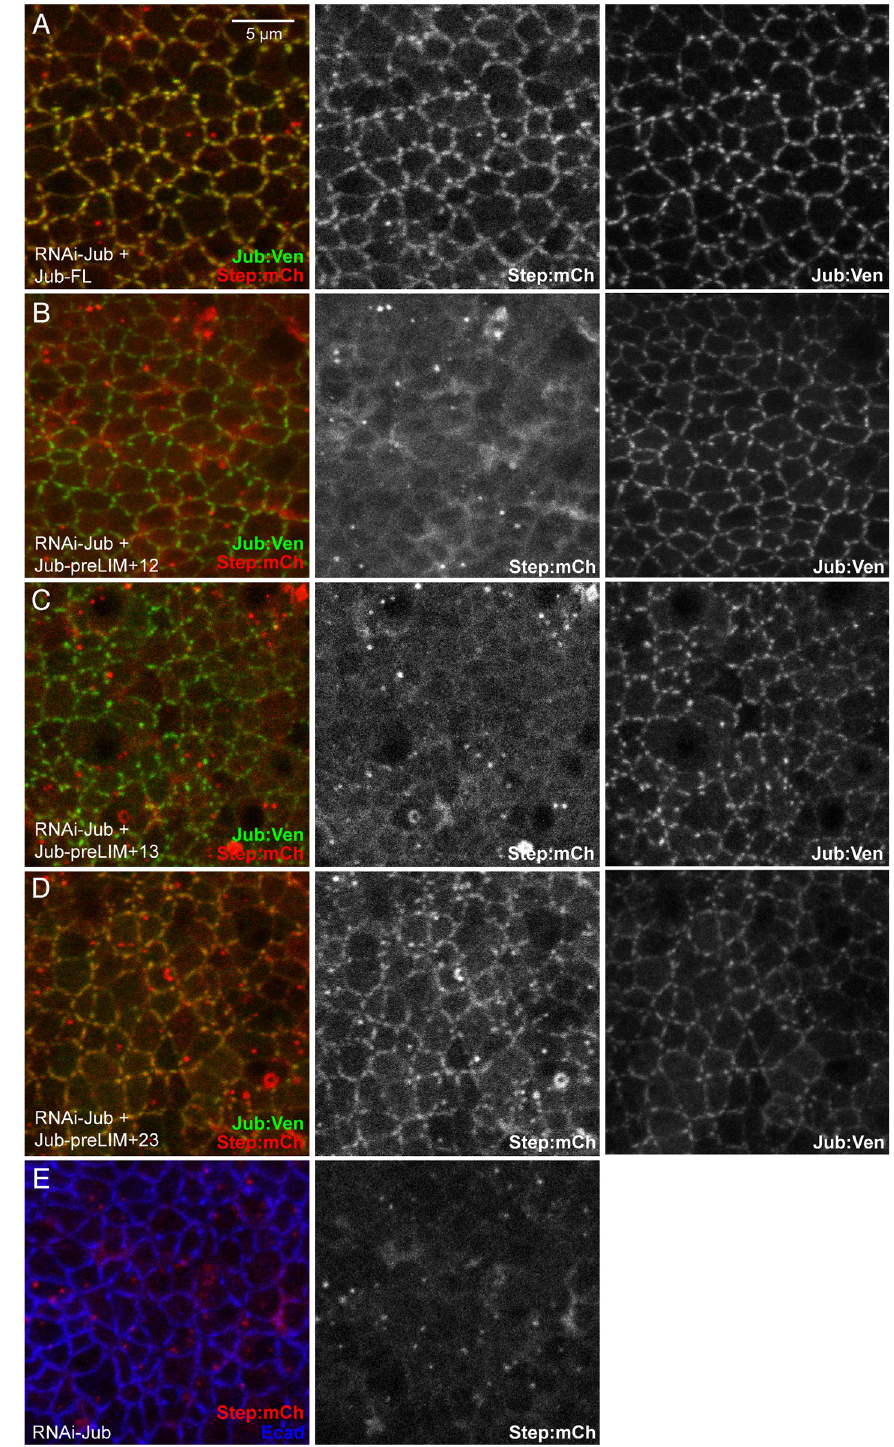
Fig 7. Rescue of junctional Step by Jub deletion constructs. A-E) Representative wing discs from larvae expressing Step:mCherry (red/white), nub-Gal4 UAS-Dcr2 and A) UAS-RNAi-jub UAS-Jub-FL : msVenus . B) UAS-RNAi-jub UAS-Jub-preLIM+12 : msVenus . C) UAS-RNAi jub UAS-Jub-preLIM+13 : msVenus . D) UAS-RNAi jub UAS-Jub-preLIM +23 : msVenus . E) UAS-RNAi-jub . All discs are shown at the same magnification (scale bar = 5 μ m).